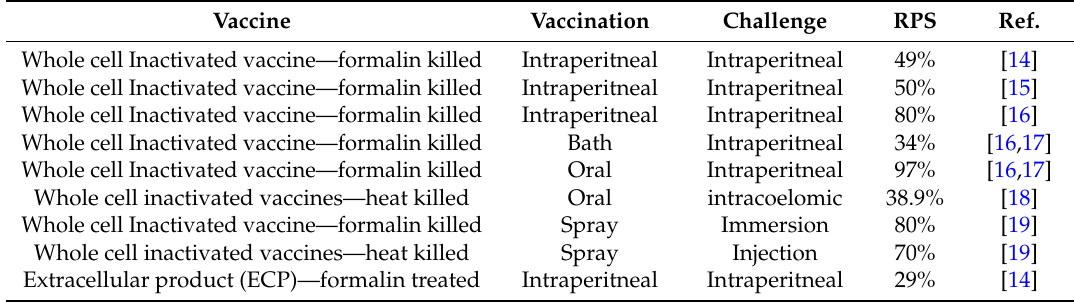
Table 2. Inactivated whole cell vaccines showing delivery systems and modalities of vaccination.